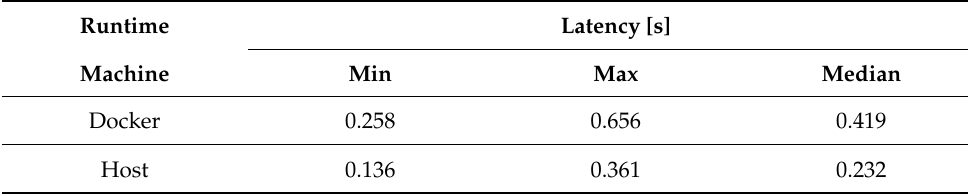
Figure 18. Network bandwidth between nodes for selected size of data; boxplot notation: medians, Q1 and Q3, max(Q1 − 1.5IQR, minimum) and min(Q3+1.5IQR, maximum) as well as potential outliers (+ for Docker, x for Host). Table 10. Minimum, maximum and median communication latency between nodes for Docker and